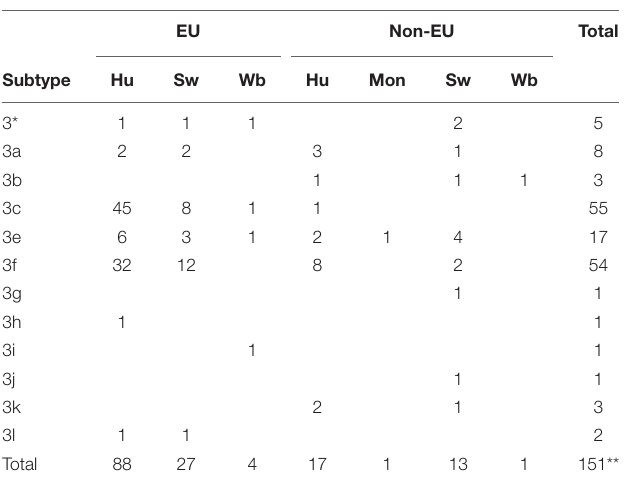
TABLE 1 | Dataset description of sequences of human and animal origin detected worldwide and used to build the tree. EU